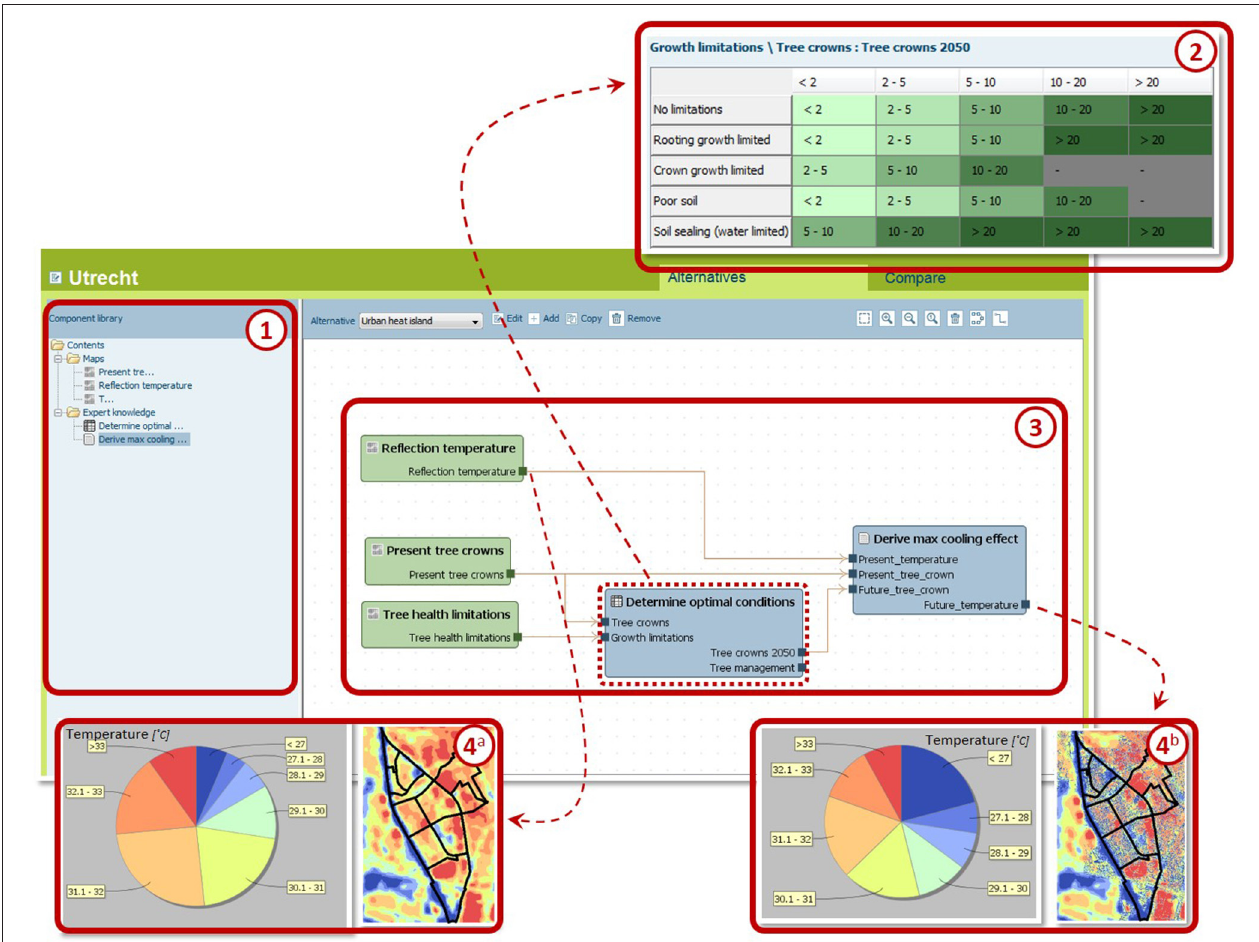
FIGURE 1 | Screen shot compilation of the QUICKScan tool. A typical QUICKScan exercise starts by populating the system’s data and rule library (1) with spatial and statistical data relevant for the study (e.g., Present tree crowns and reflection temperature). (2) Is an example of an if…then...else rule defining the relationship between tree crown size and conditions limiting tree health (which can be manipulated to influence evaporation and therefore the heat reduction effect). Such rules are drafted by workshop participants, based on their joint knowledge. Data and rules are dragged onto the canvas and linked together forming a chain [see (3)]. Rules are applied to the data to create maps and charts [(4a) for the present temperature overlaid by a line map delimiting neighborhoods and (4b) for the effect of healthy full grown trees on the temperature]. The rule to “derive max cooling effect” based on temperature tree crown size is not explicitly